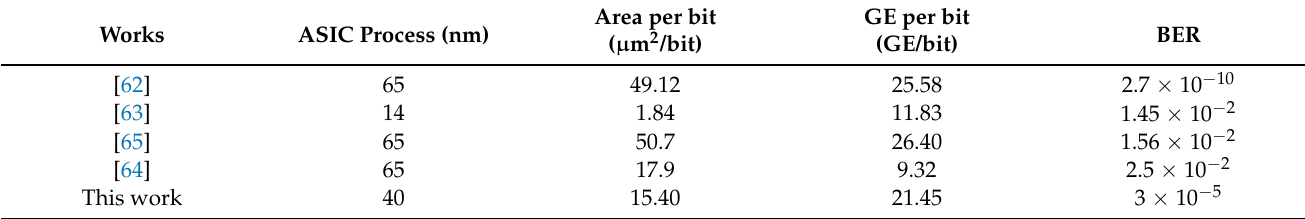
Table 7. PUF implementation results